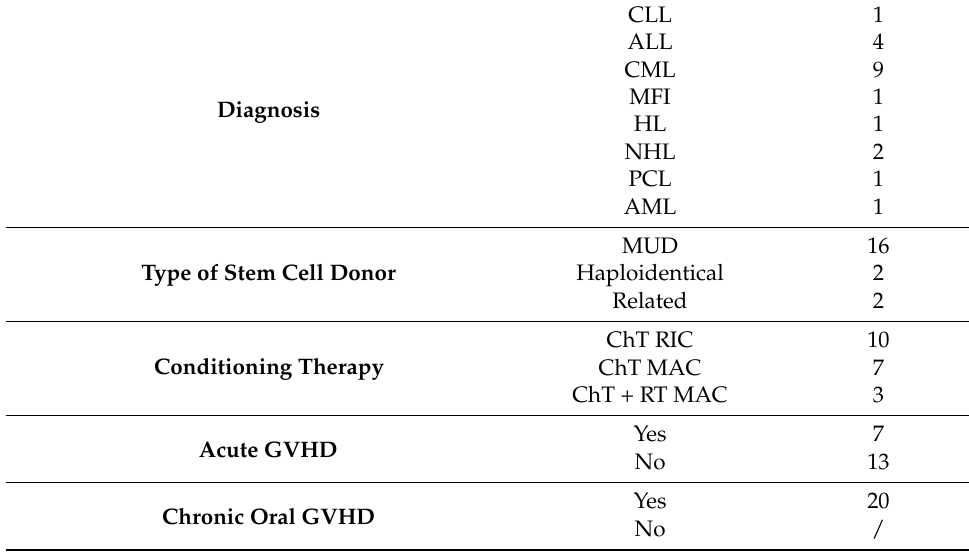
Table 2. Hematopoietic stem cell transplant (HSTC)